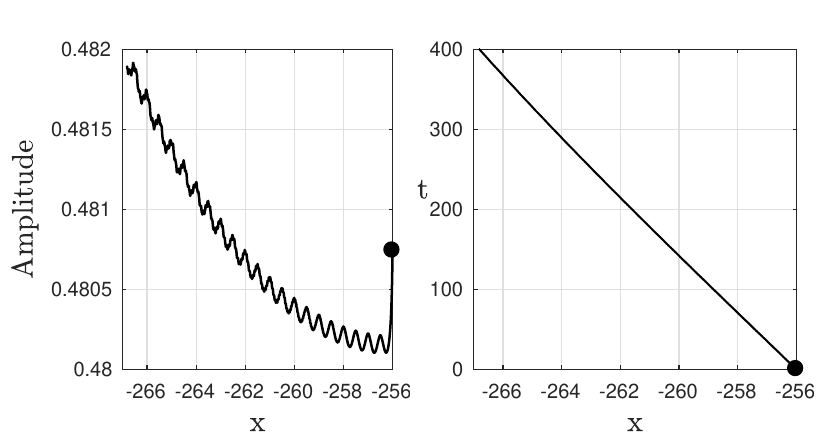
Figure 7. Left : the space amplitude vs. crest position. Right : the crest position along the time. The parameters are the same as in Figure 6 with n =